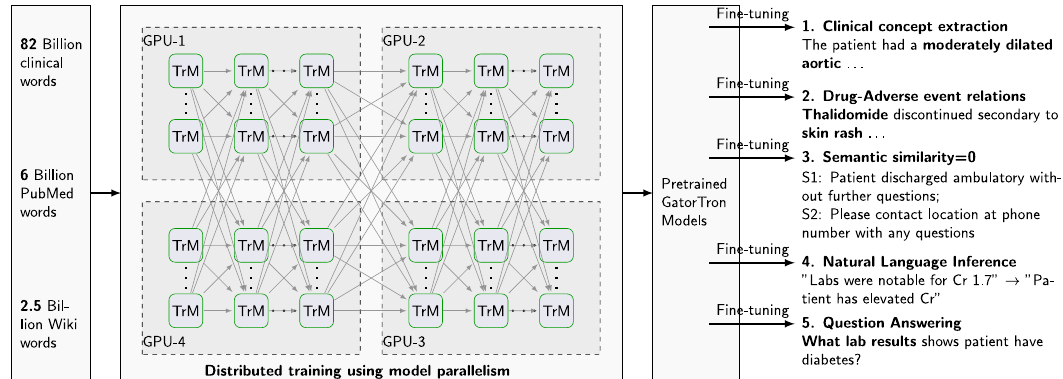
Fig. 3 An overview of pretraining and fi ne-tuning of GatorTron models. We loaded the base model and the medium model into one GPU for distributed training. We sliced the GatorTron-large model into 4 pieces and loaded model pieces to 4 GPUs for distributed training (i.e., model parallelism). TrM transformer unit.